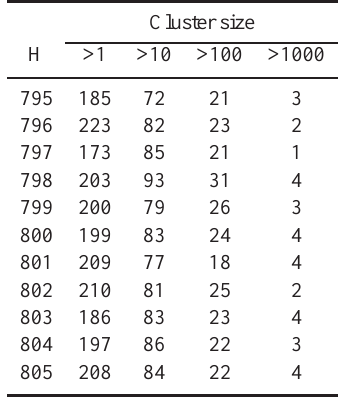
Table 3. Dependence of cluster distribution on the weight of